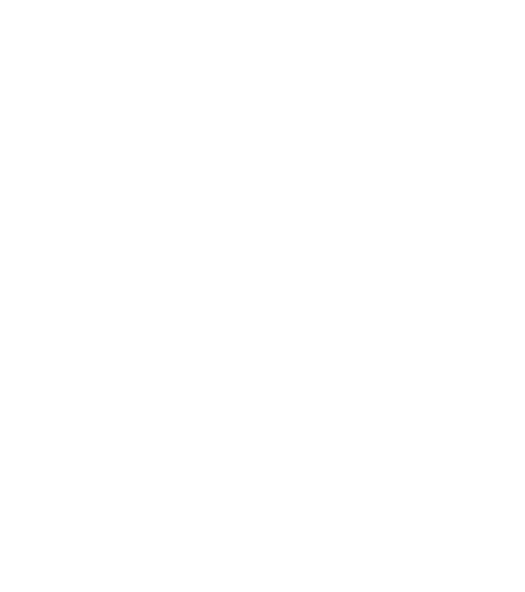
Table 3. Results of regression performed with specific insurance plans. *Reaches statistical significance (p <